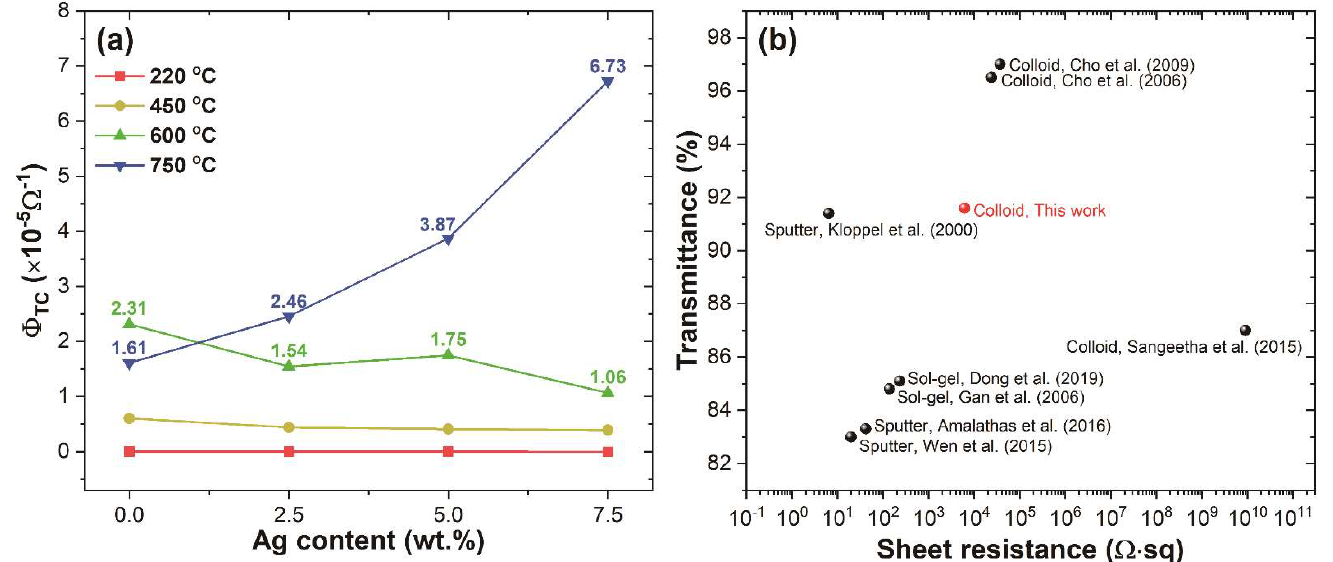
Figure 10. ( a ) The figure of merit (FOM) of ITO and ITO@Ag thin films according to the weight percentage of silver and thermal-treatment temperature, and ( b ) graphical representation of op- tical transmittance and sheet resistance for sputter, data from Refs. [54,61,62], sol-gel, data from Refs. [63,64], and colloid processed, data from Refs. [58–60] ITO thin